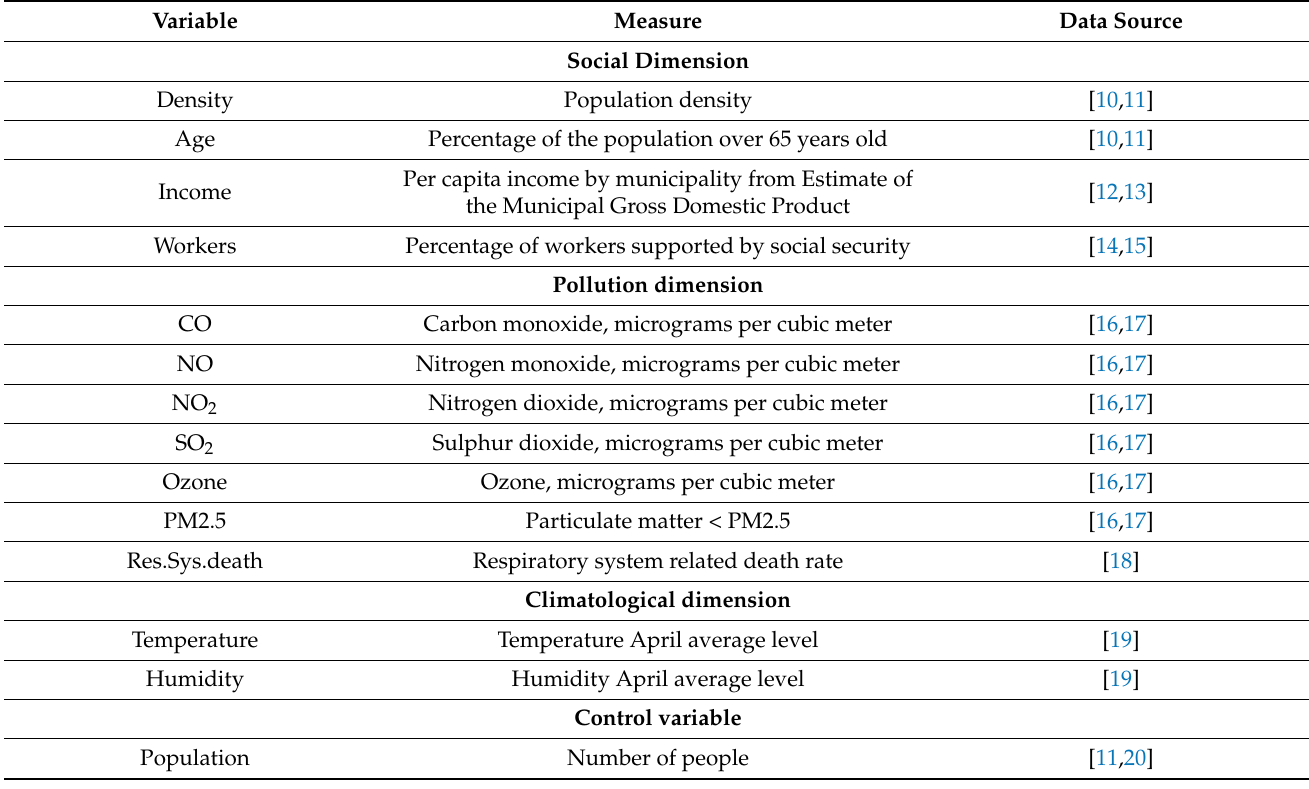
Table 1. Summary of independent